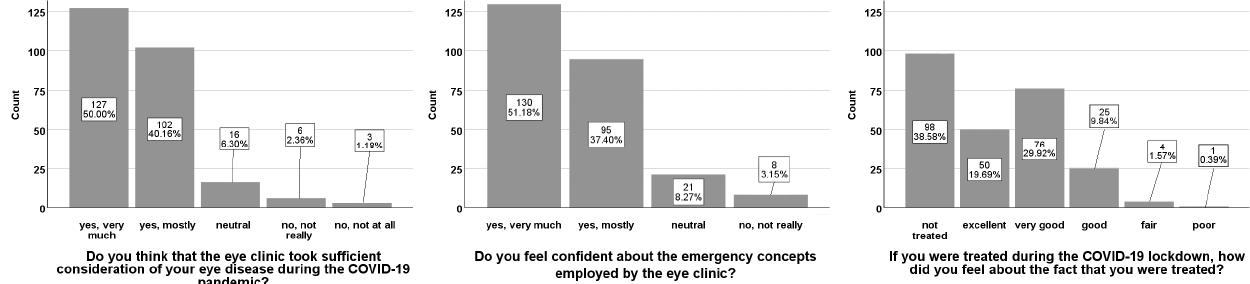
Figure 4. Results from the additional questionnaire assessments. Answers to the questions “Do you think that the eye clinic took sufficient consideration of your eye disease during the COVID-19 pandemic?”, “Do you feel confident about the emergency concepts employed by the eye clinic?”, “If you were treated during the COVID-19 lockdown, how did you feel about the fact that you were treated?” Results for each bar are shown in absolute numbers and percentages.